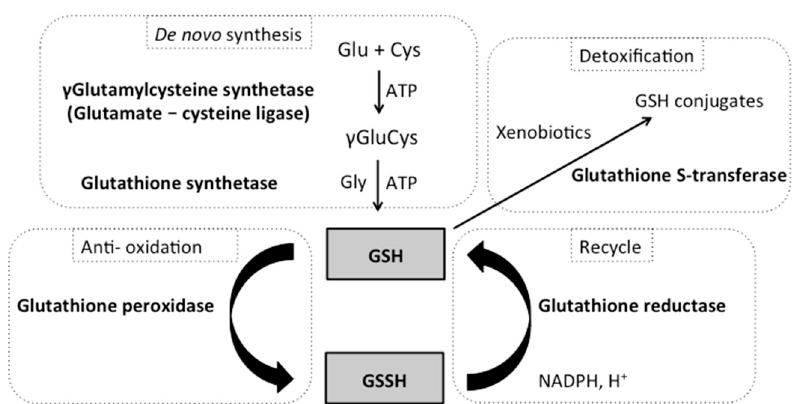
Figure 1. The glutathione pathway in Saccharomyces cerevisiae . The synthesis of glutathione (GSH) is a two-step process catalyzed by the enzyme γ -glutamylcysteine synthetase ( GSH1 ) and glutathione synthetase ( GSH2 ) in the cytoplasm. GSH plays a crucial role in the protection of macromolecules from stressors, especially oxidants. The reduced form (GSH) directly scavenges diverse oxidants and xenobiotics via the action of glutathione peroxidase ( GPX1-3 ) and glutathione S-transferase ( GST ) and becomes oxidized (GSSH). Regeneration of oxidized GSSG to reduced GSH is catalyzed by glutathione reductase ( GLR1 ) (requires NADPH).